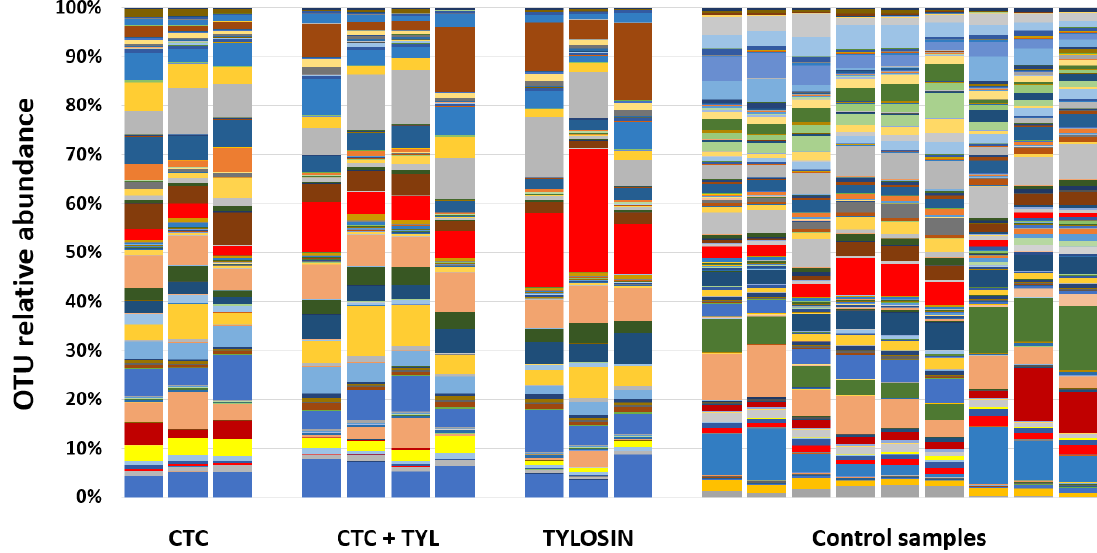
Figure 12. The stacked bar chart at the best taxonomic resolution.